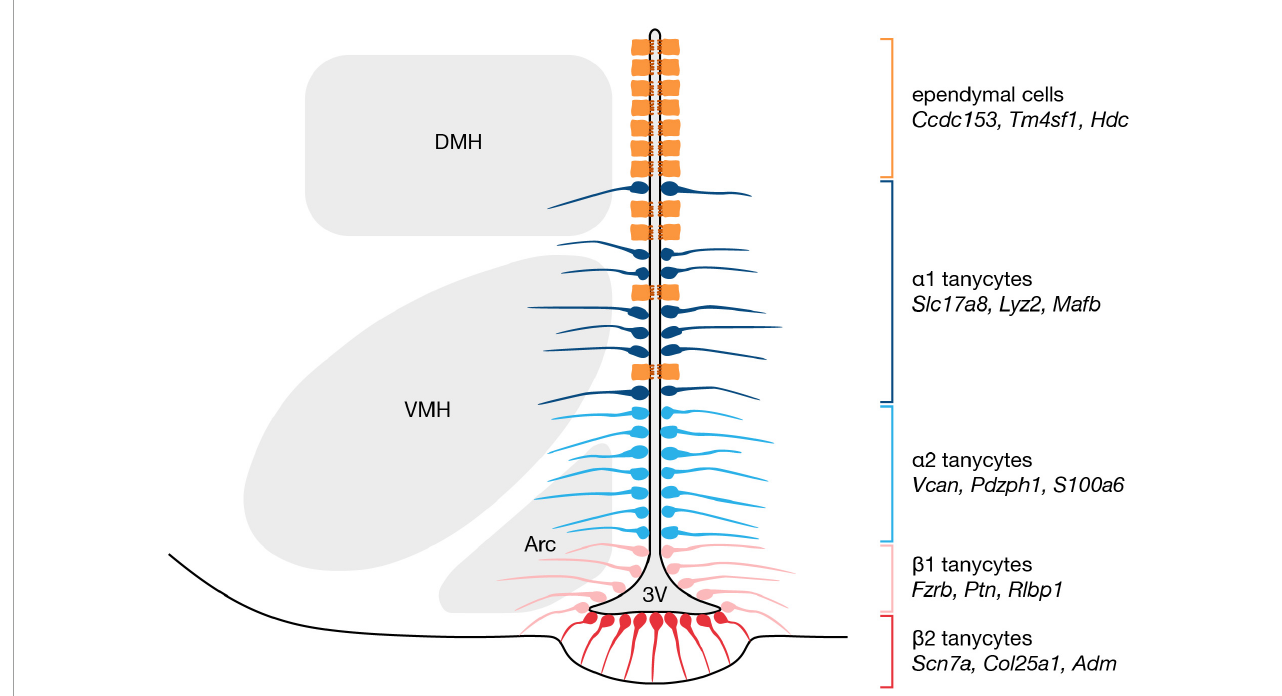
FIGURE1 Organization and markers of tanycytes subtypes along the hypothalamic third ventricle. Tanycytes are classified into four subtypes according to dorsoventral location, and recent scRNA-seq studies have identified marker genes for each subtype (Campbell et al., 2017; Chen et al., 2017; Sullivan et al., 2022). α 1 tanycytes are the most dorsally located subtype, followed by α 2 tanycytes, then β 1 tanycytes, and finally β 2 tanycytes which occupy the ventricular floor. 3V, third ventricle; Arc, arcuate nucleus; DMH, dorsomedial hypothalamic nucleus; VMH, ventromedial hypothalamic